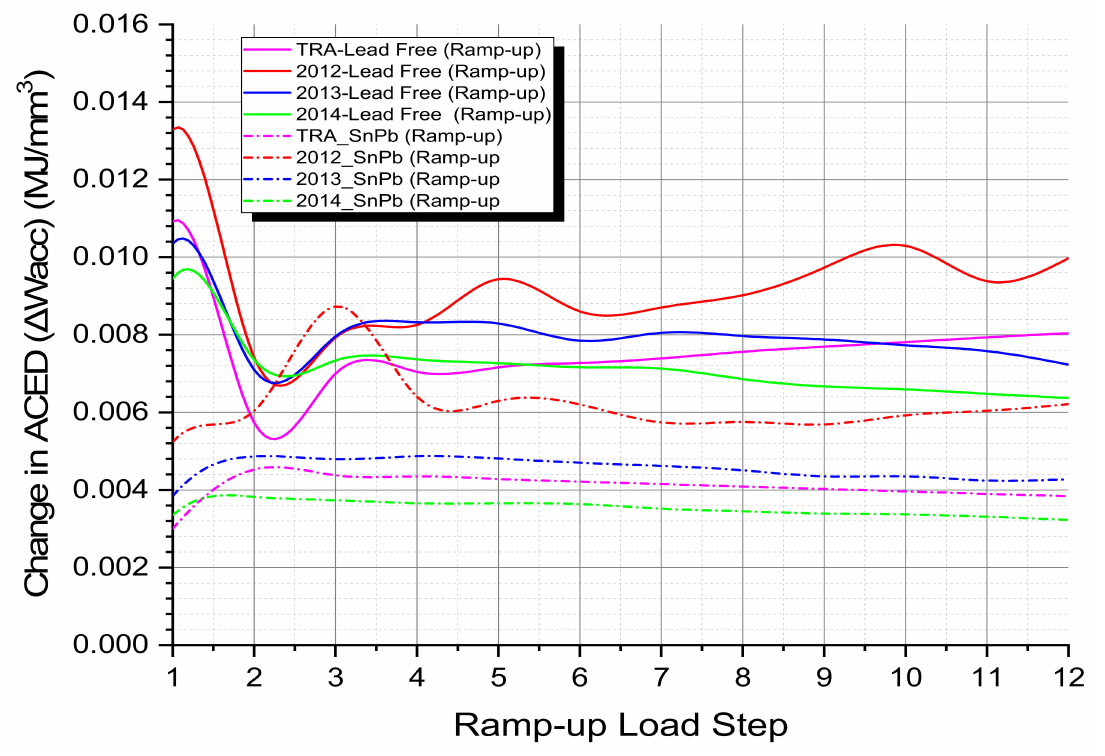
Figure 12. ACED damage accumulation from ramp-up load step.